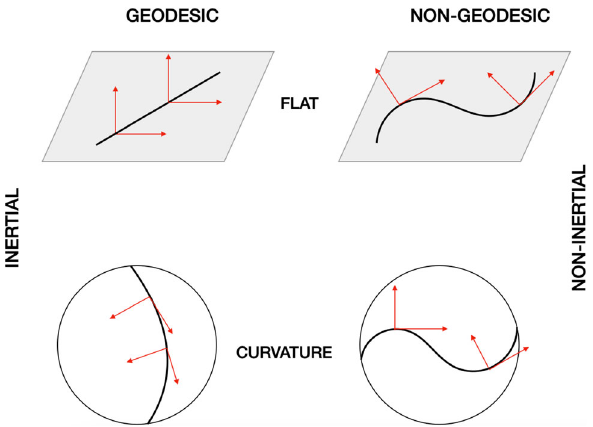
Fig. 5 This figure shows how tetrads behave in terms of inertial and gravitational effects. When no gravity is present, and we consider iner- tial effects only (i.e., we move along geodesics), we obtain trivial (holo- nomic) tetrads, whereas when non-inertial contributions take place (i.e., following non-geodesic orbits) the tetrads become anholonomic. The situation is analogue when gravitation is switched on. Along geodesic we obtain inertial frames, whereas along non-geodesic trajectories we have the most general anholonomic